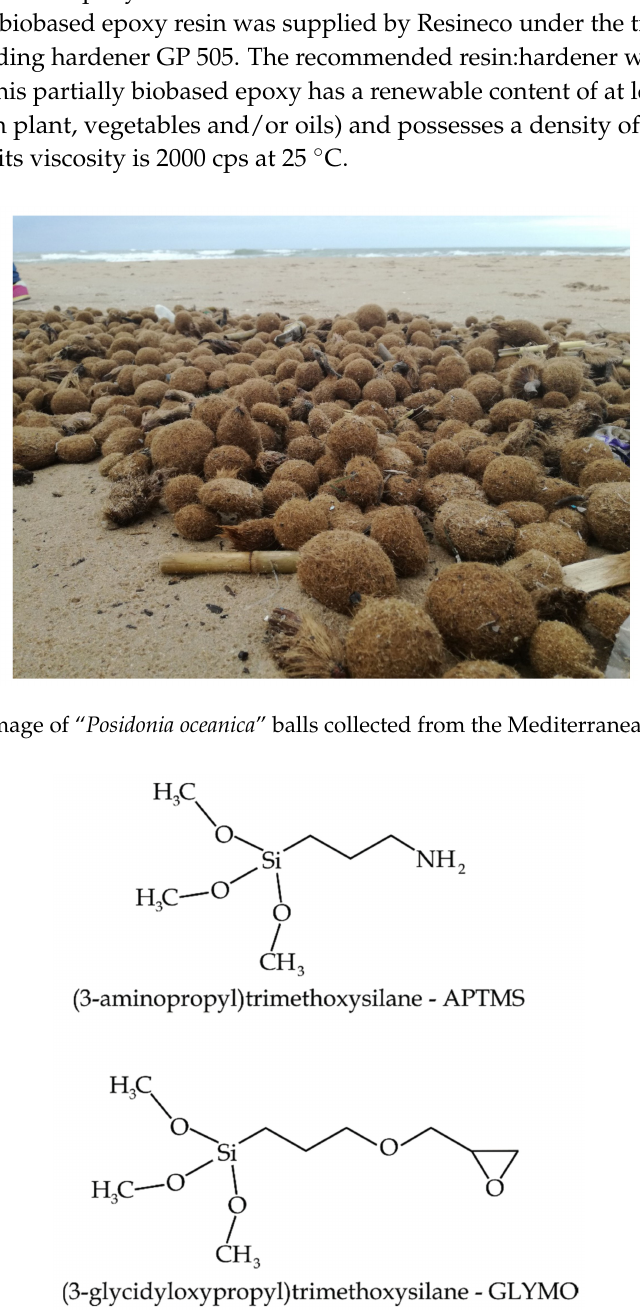
Scheme 1. Schematic representation of the chemical structure of the silane-coupling